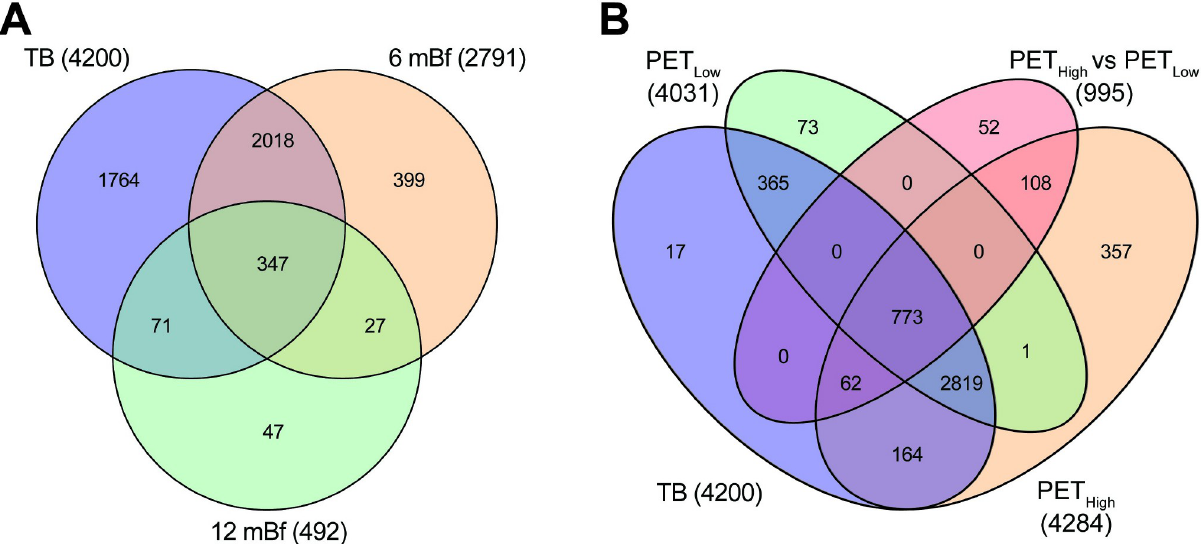
Fig 1. Venn diagram illustrating the overlap in significantly upregulated genes. A) Comparison of upregulated genes detected 7–12 and 1–6 months before diagnosis and in TB patients. B) Comparison of upregulated genes detected in TB patients with high and low PET scores compared separately to controls and high and low PET scores compared to each other. The numbers in parenthesis indicate the total number of upregulated genes for the specific comparison.